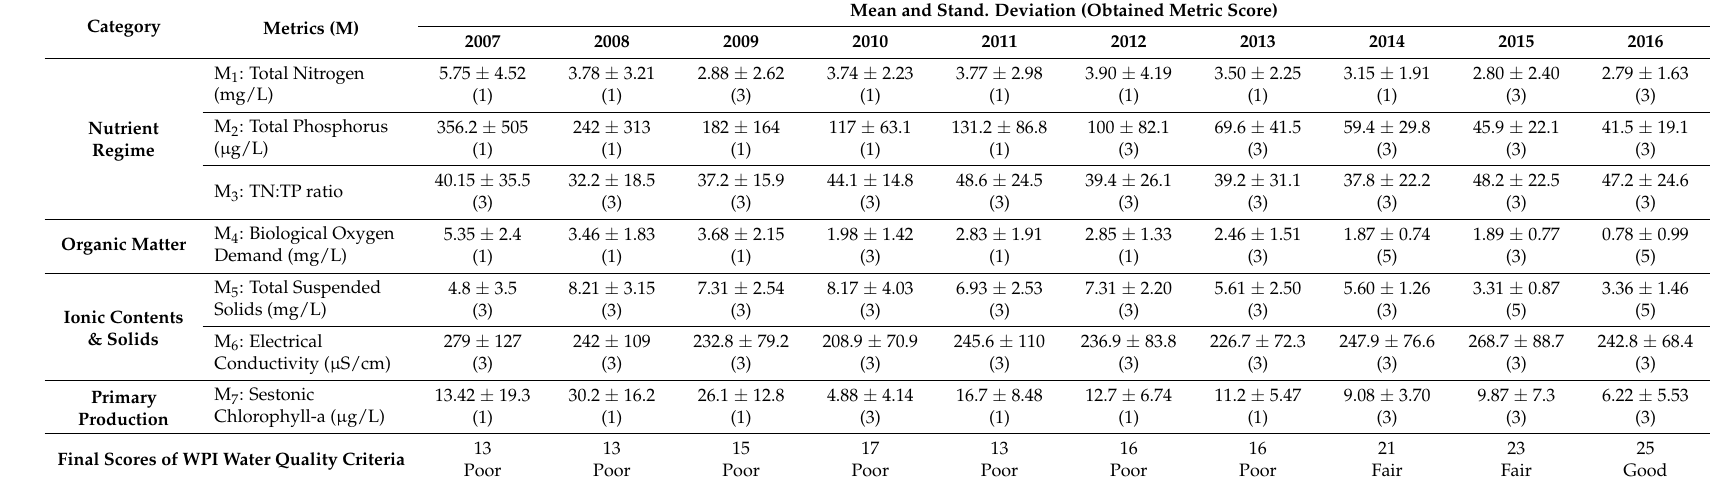
Table 3. Annual results of water pollution index (WPI) and water quality status evaluation in Gap Stream during 2007–2016.